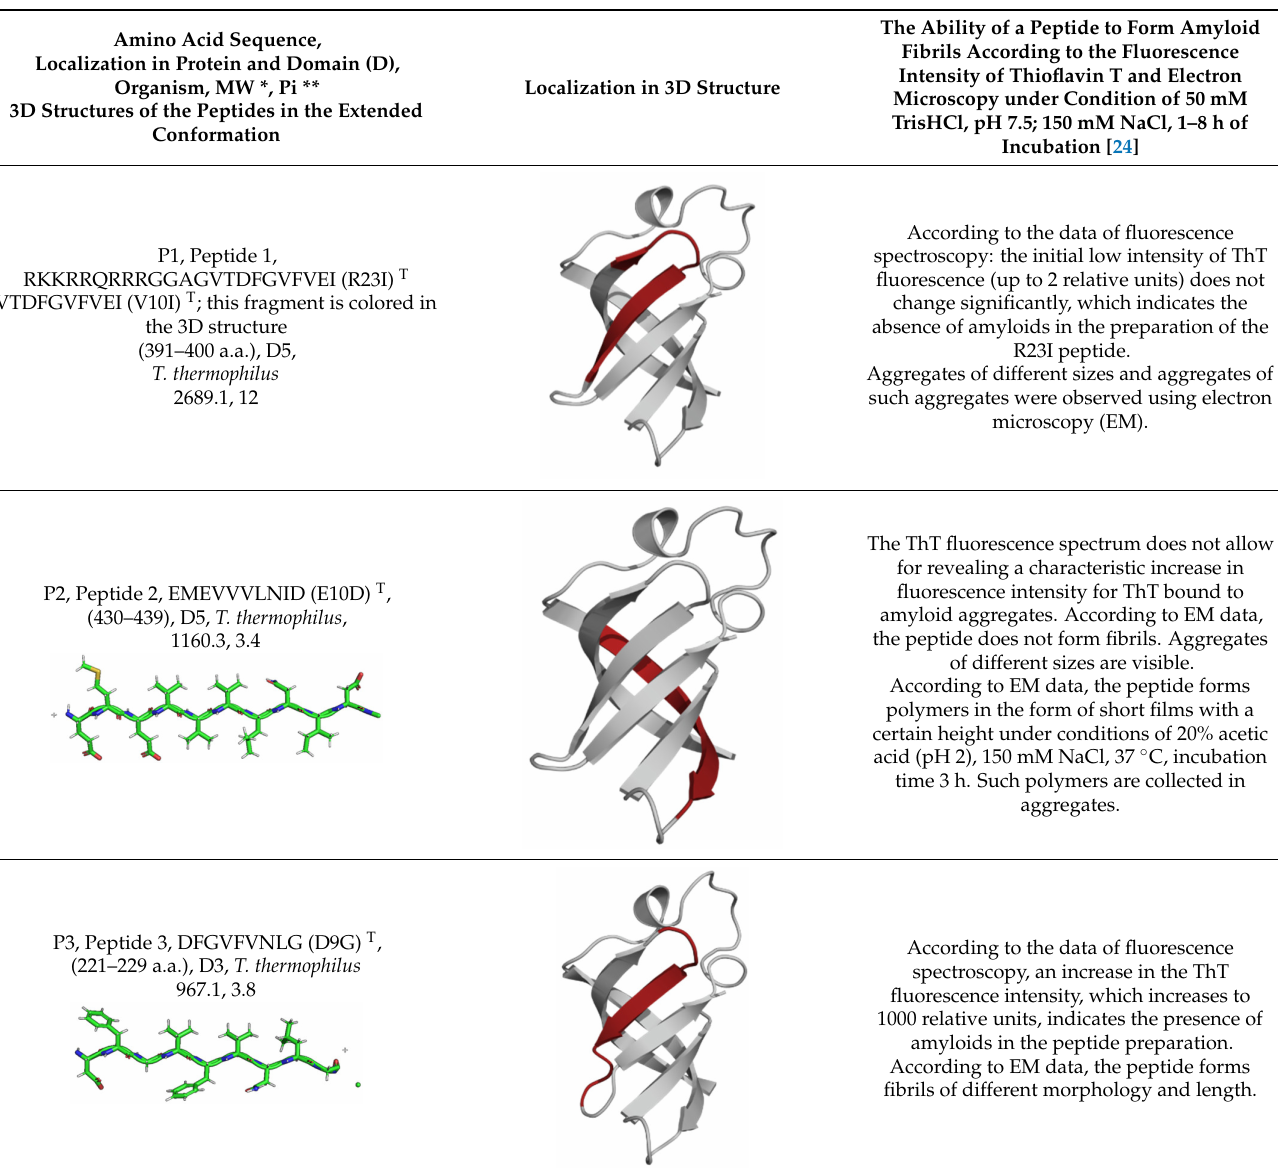
Table 1. List of amyloidogenic peptides with antibacterial potential from Escherichia coli ( E. coli ) and Thermus thermophilus ( T. thermophilus